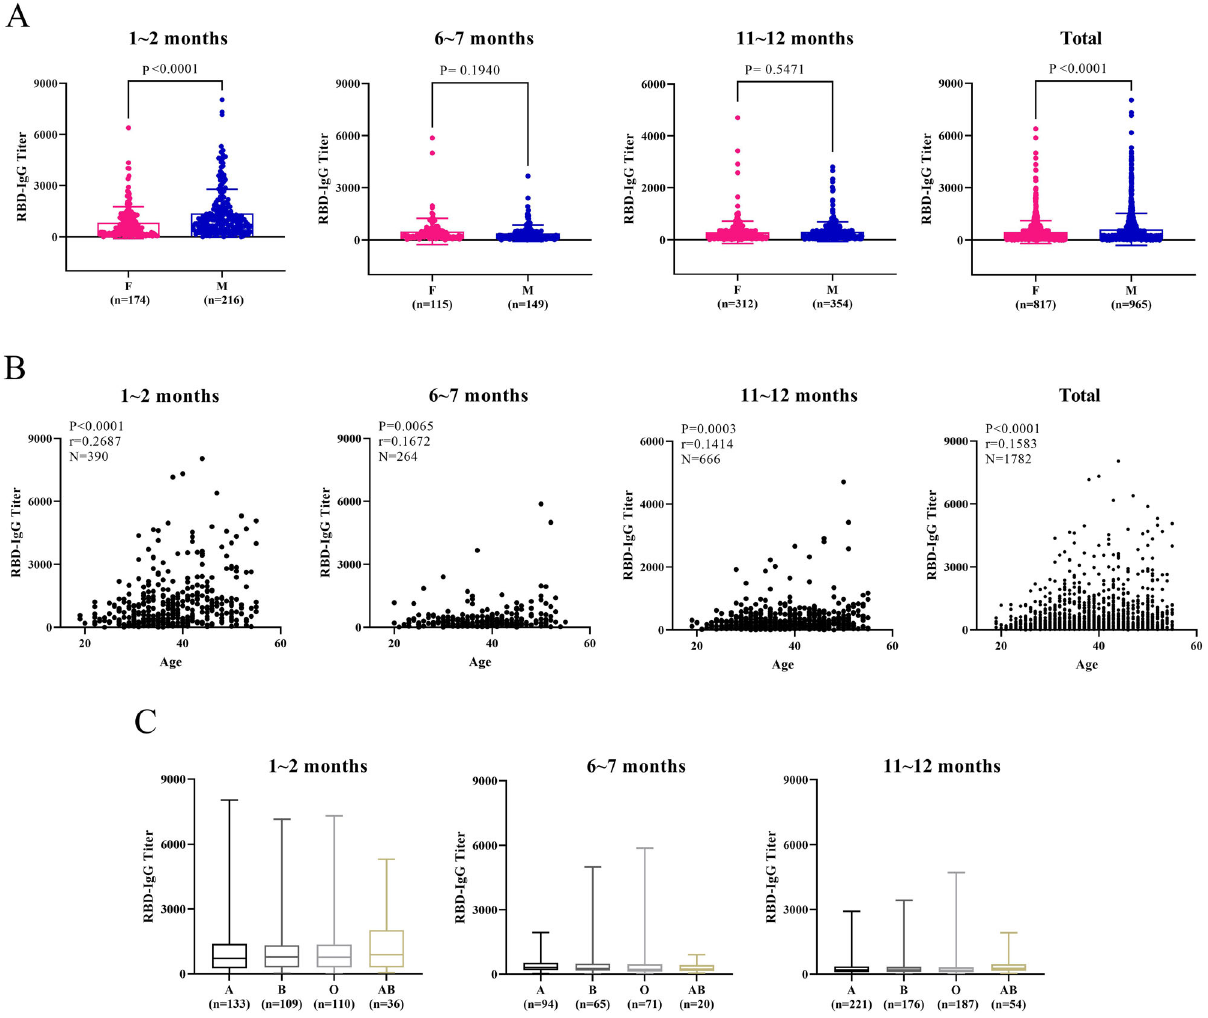
Fig. 4 In fl uences of gender, age, and blood types on RBD-IgG response in COVID-19 plasma donors at different stages following diagnosis. ( A ) is gender comparison (male compared with female). Two-way ANOVA and a two-tail unpaired t test with Welch ’ s correction are used to test the difference between genders. Error bar in gender indicates mean with SD. F, female. M, male. ( B ) Age has a positive correlation with the RBD-IgG titer. Two-tailed Pearson correlation test was used to examine the association between age and RBD-IgG titers. ( C ) Insigni fi cant difference was found between blood types of the plasma donors with the RBD-IgG titers. Box in blood groups indicates median and quartiles, while whiskers indicate maximum to minimum. A, B, O, and AB are Blood